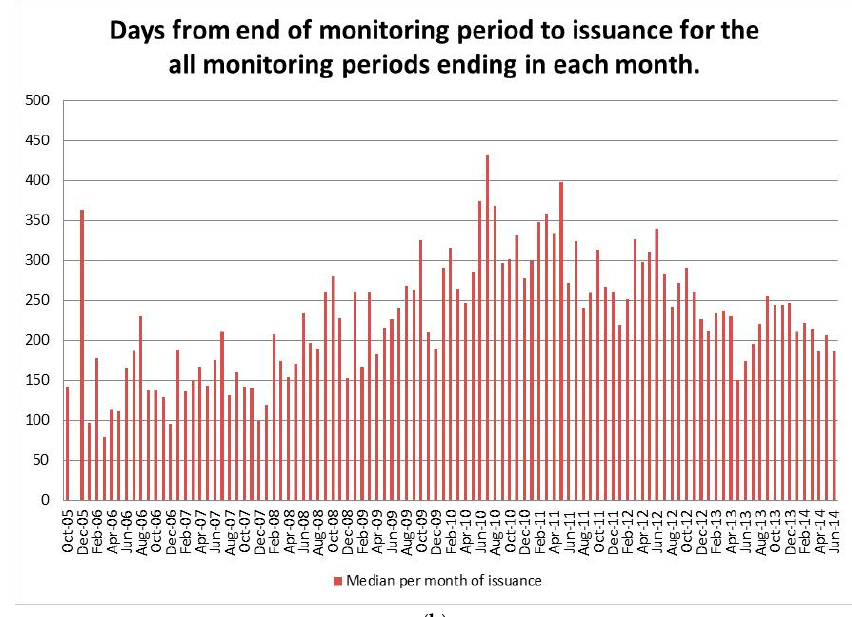
Figure 4. ( a ) Average time from registration request until registration in days; ( b ) Median per month